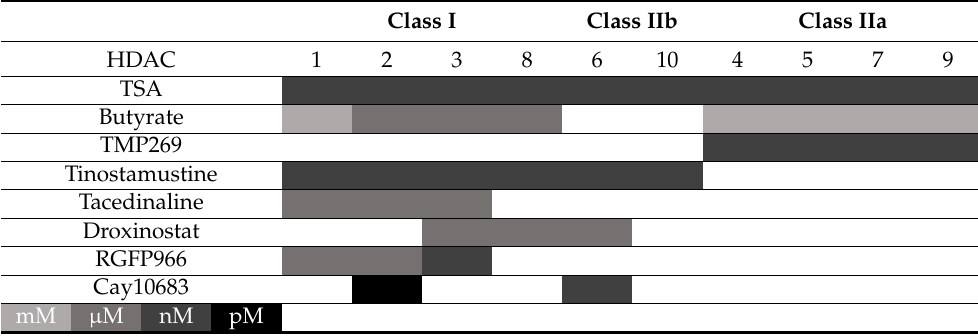
Table 1. HDAC inhibition by specific HDAC inhibitors, categorized per class. Intensity in color indicates half-maximal inhibitory concentration of the HDAC inhibitor in mM, µ M, nM or pM range (light grey to black). Class I Class IIb Class